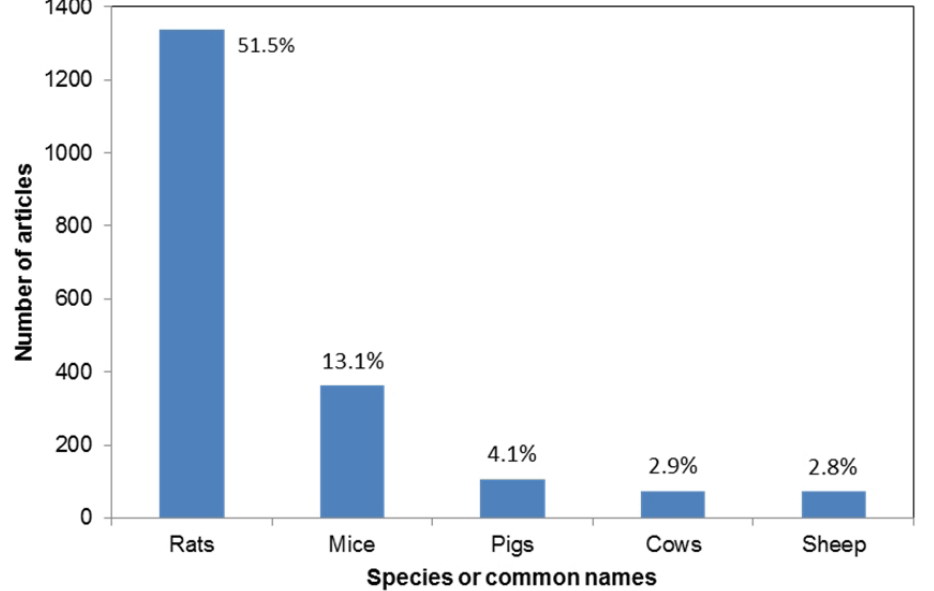
Figure 2. The number of reviewed articles using each of the top five species or common names. Data labels refer to the percentage of the total